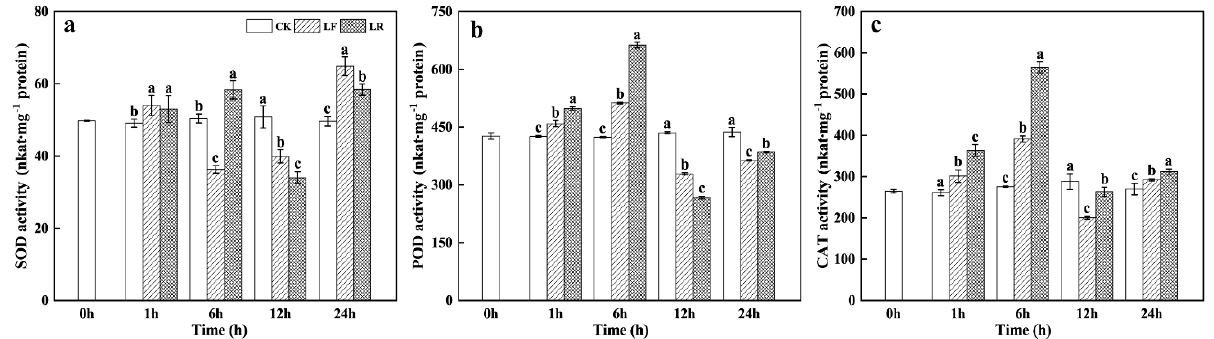
Figure 4. Effects of leaf removal on SOD ( a ), POD ( b ), and CAT ( c ) activities in the roots of M. baccata under suboptimal low root–zone temperatures. Data are means ( ± SE) for three replicates per treatment at each time point independently. Different letters on the bars indicate significant differences between treatments.